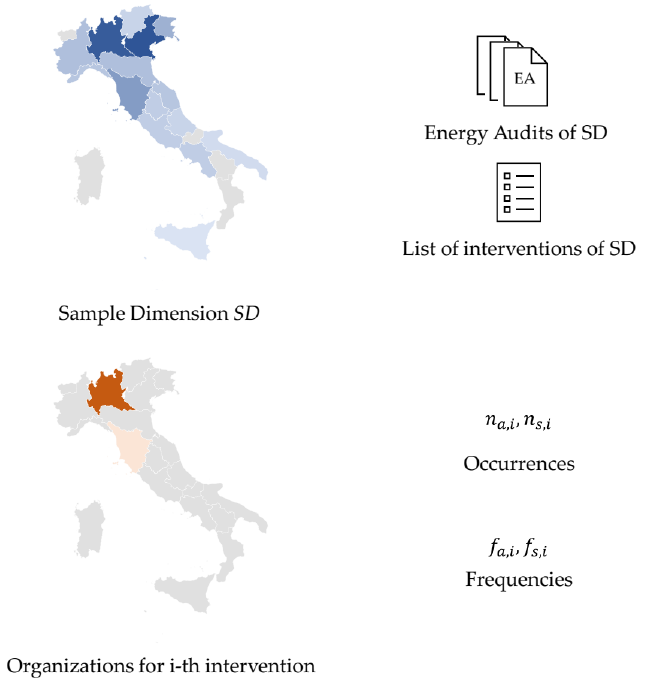
Figure 2. Schematic representation of parameters’ meaning and assessment